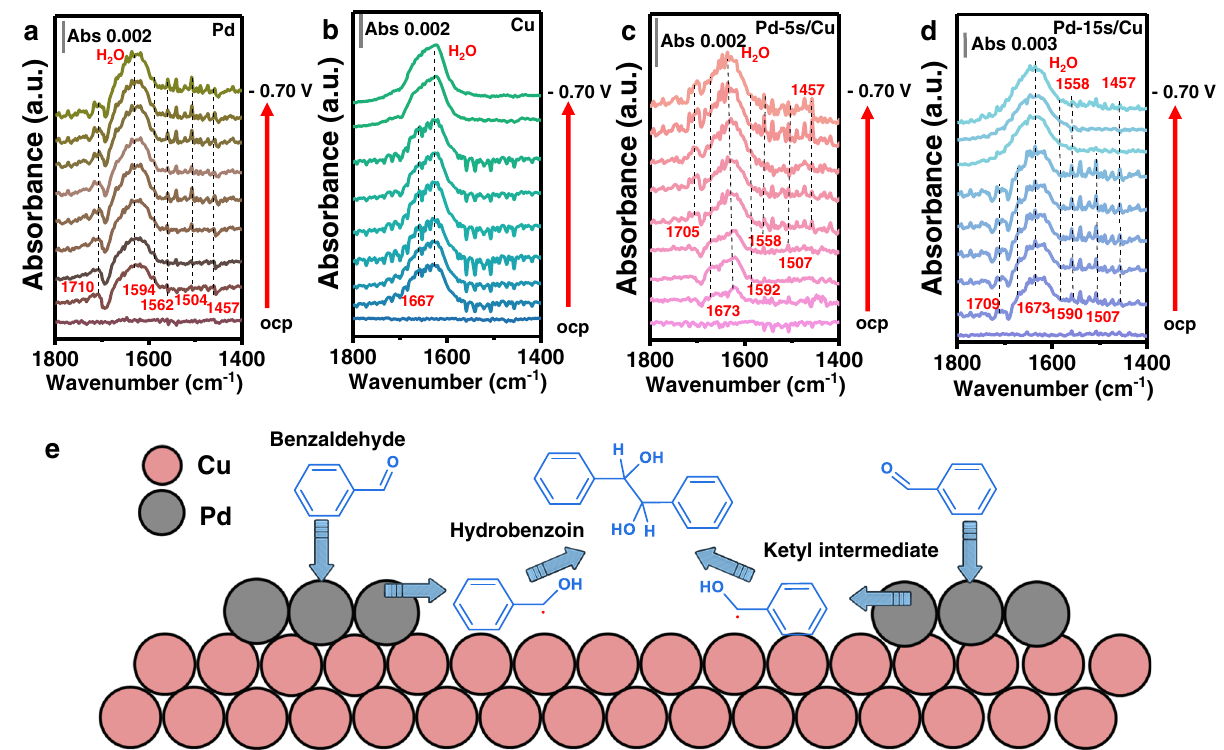
Fig. 3 | In situ ATR-SEIRAS investigation of Pd/Cu catalysts. a – d In situ ATR-SEIRAS spectra of Pd ( a ), Cu ( b ), Pd-5s/Cu ( c ), and Pd-15s/Cu ( d ). e Proposed reaction mechanism for the electroreductive coupling of benzaldehyde to